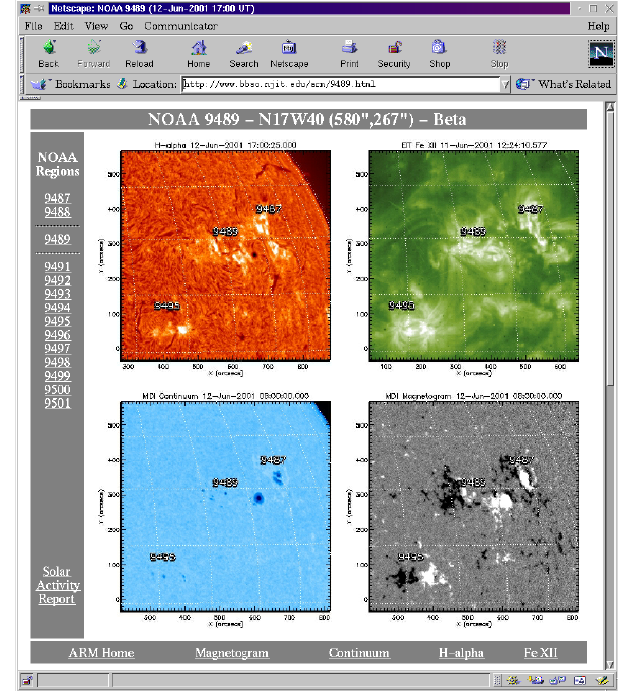
Fig. 4. Snap-shot from ARM showing a 10 0 × 10 0 zoom of NOAA active region 9489. Clockwise from top left, ARM shows BBSO H α , EIT Fe XII , MDI magnetogram, and MDI continuum.